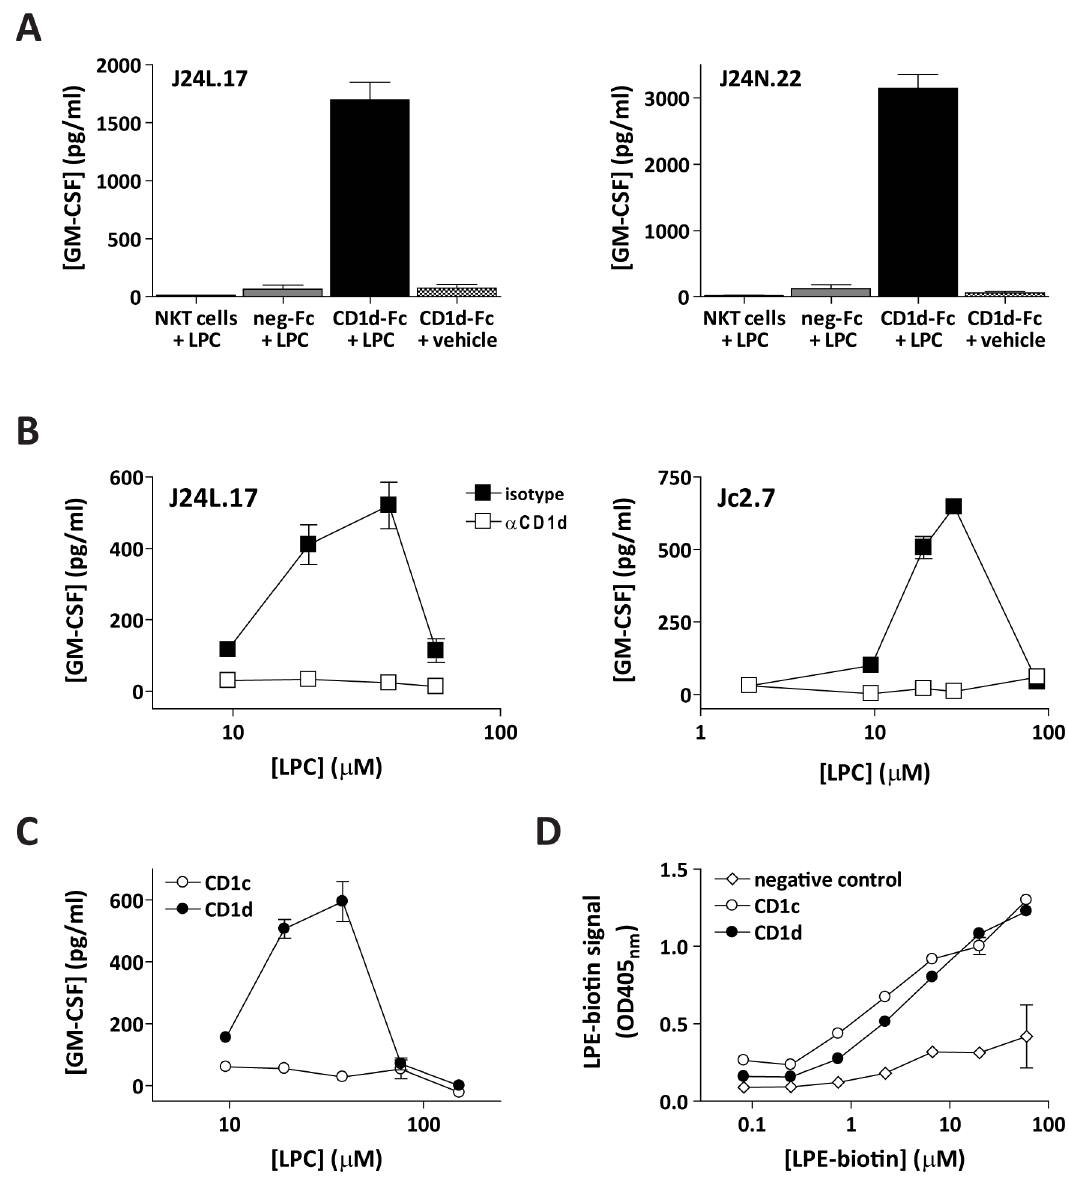
Figure 3. Responses to LPC are due to CD1d-mediated presentation. (A) NKT cell clones J24L.17 and J24N.22 were incubated directly with 20 m M of LPC (far left), with immobilized negative control antibody pulsed with 20 m M of LPC (second from left), immobilized CD1d-Fc molecules pulsed with 20 m M of LPC (second from right), or with immobilized CD1d-Fc pulsed with vehicle (far right), and cytokine secretion was quantitated by ELISA. Similar results were observed in four independent assays. (B) Responses of NKT cell clones JC2.7 and J24L.17 to CD1d molecules pulsed with LPC were blocked by inclusion of an anti-CD1d antibody but not an isotype-matched negative control antibody. Similar results were observed in two independent assays. (C) NKT cells respond to LPC-pulsed CD1d molecules, but not to the related isoform CD1c. The plot shows one representative experiment out of two, using clone J3N.5. Similar results were observed with three other NKT cell clones. (D) Biotinylated C18:1 LPE binds similarly to CD1d and CD1c molecules. Similar results were observed in three independent